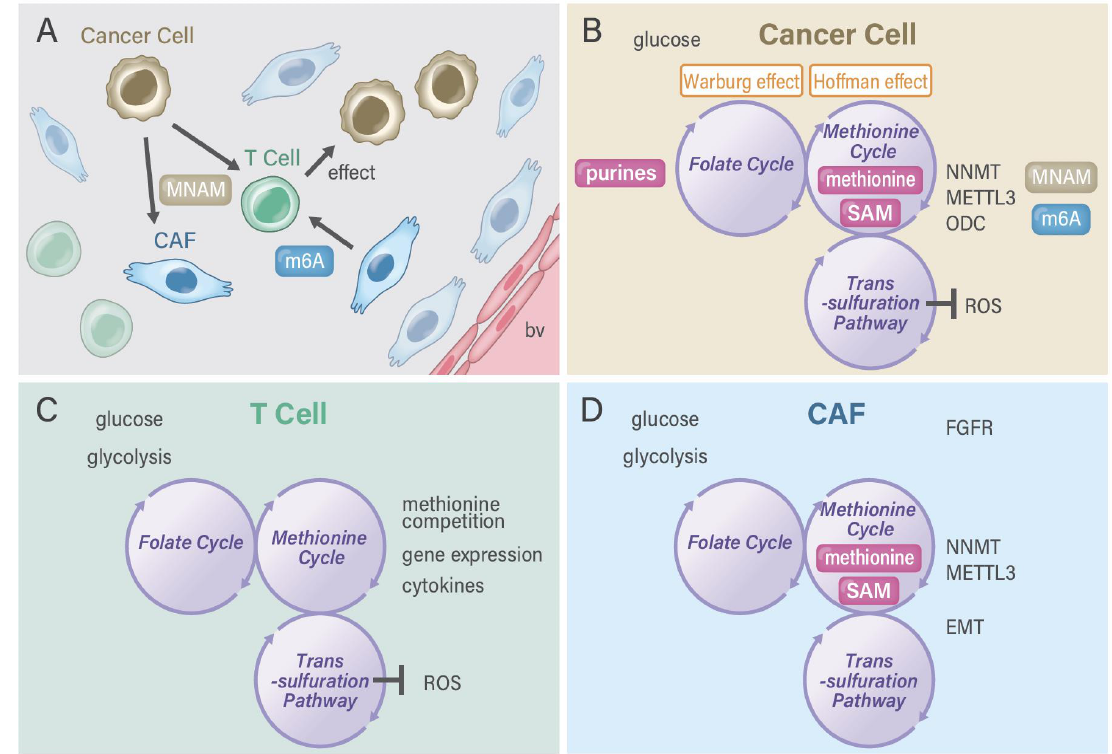
Figure 5. Methylosystem in the tumor microenvironment. ( A ) Various cells exist in the tumor microenvironment, includ- ing cancer cells, immune cells, and cancer-associated fibroblasts. ( B ) Cancer cells possess activated one-carbon metabolism, which comprises the folate cycle, methionine cycle, and trans-sulfuration pathway. One-carbon metabolism collaborates with the Warburg and Hoffman effects. Cancer cells can secrete microRNAs with m6A from the RNA methylation path- way and MNAM from the NAD+ salvage pathway. METTL3 function is connected with NNMT in CD44v3 cancer cells [71]. ( C ) T cells have unique redox regulation as the trans-sulfuration pathway of one-carbon metabolism plays a critical role in the maintenance and execution of T cell function [25]. ( D ) Pathway of one-carbon metabolism plays a role in mainte- nance of CAFs, which communicate with surrounding cells including T cells and cancer cells. CAF, cancer-associated fibroblast; ODC, ornithine decarboxylase; FGFR, fibroblast growth factor receptor; EMT, epithelial-mesenchymal transi- tion; bv, blood vessels; MNAM,